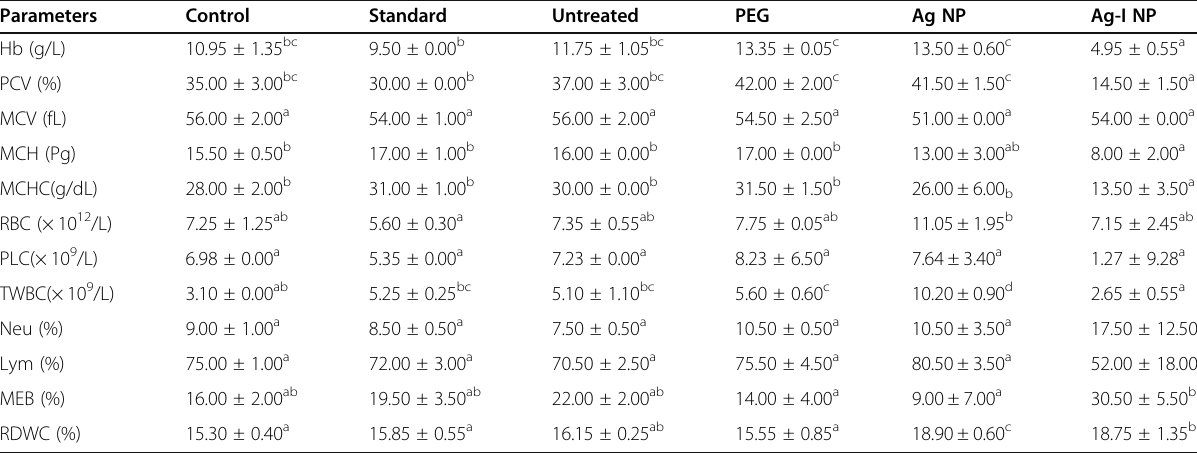
Biochemical analysis Values are expressed in mean±standard error of mean. Values with the same superscript across the row have no significant different at p